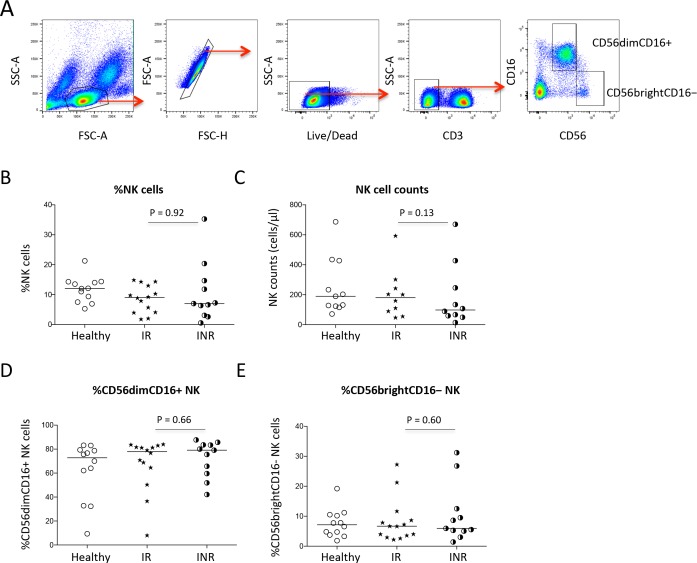
NK cells and subsets distribution.Blood samples were stained with fluorescent-labeled antibodies and tested by flow cytometry. (A) Representative dot plots, showing the gating strategies used to assess NK cells, and CD56dimCD16+ or CD56brightCD16− NK cell subsets. The median frequency (B) and absolute count (C) of NK cells were shown in immunologic non-responders, immunologic responders, and healthy controls. The median frequencies of CD56dimCD16+ (D) or CD56brightCD16− subsets (E) in NK cells were shown in the three study groups.